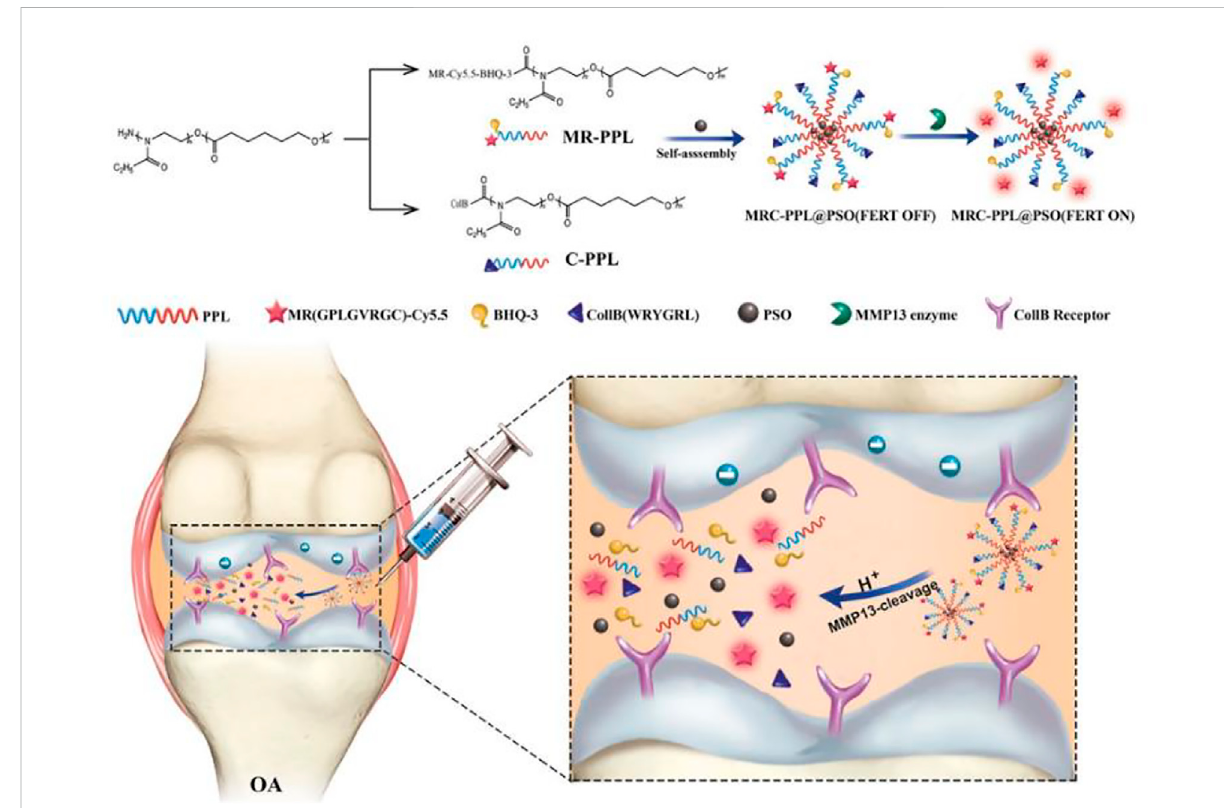
FIGURE 2 Schematic illustration of the synthesis and working mechanism of MMP-13 and pH responsive theranostic MRC-PPL@PSO nano-micelles for OA (Lan et al., 2020). Copyright, 2020,